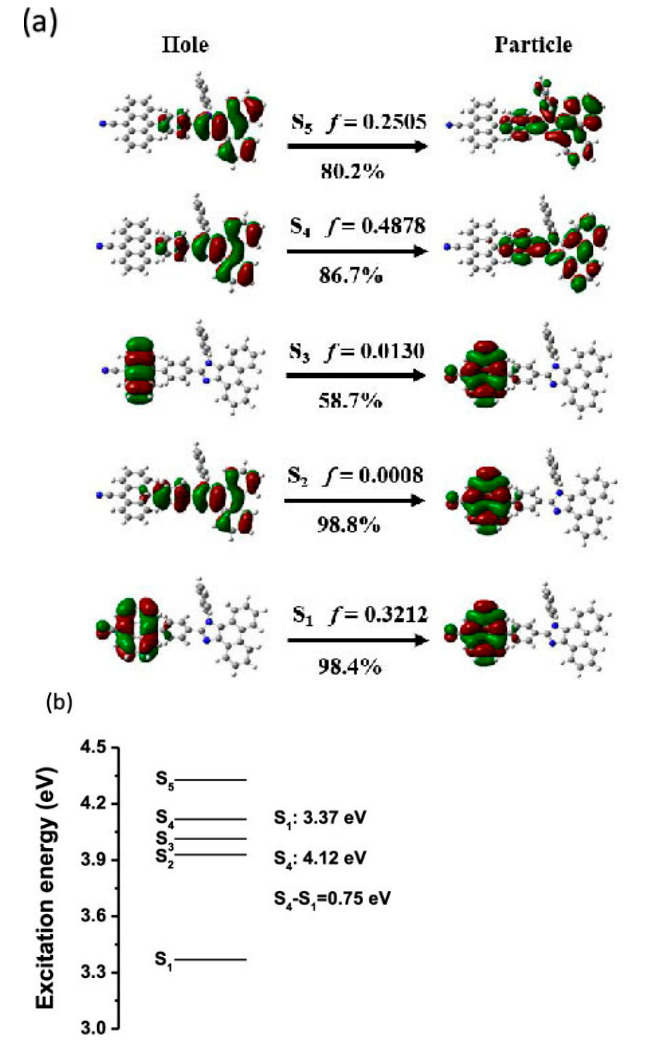
Figure 11. ( a ) Natural transition orbitals of 43 ; ( b ) the energy landscape for singlet states of 43 . Reprinted/adapted with permission from [54], Copyright 2019, American Chemical Society.